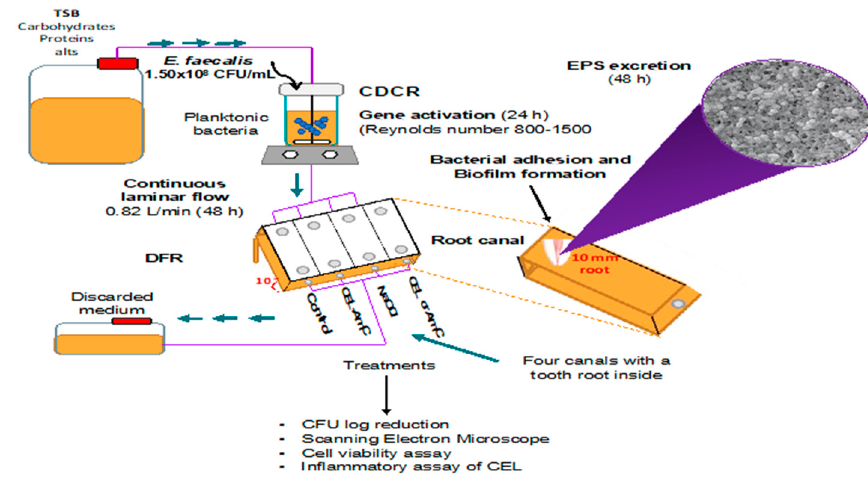
Figure 1. Scheme representing a Center for Disease Control reactor. CDCR, CDC reactor; DFR, drip flow reactor; TSB, trypticase soy broth; EPS, extracellular polymeric substances; CEL, hydrolase; AmC, amoxicillin/clavulanic acid; CFU, colony-forming units.